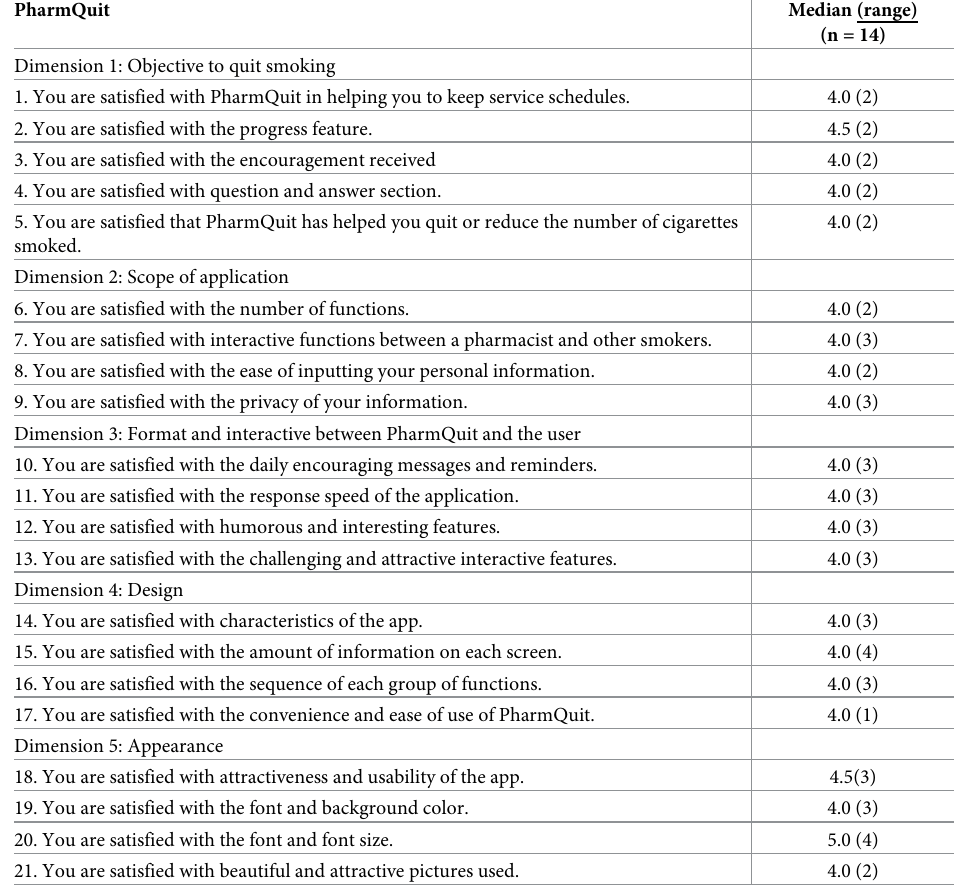
Table 8. Satisfaction score (on a scale of 1–5) to PharmQuit in the intervention group at 6 months.